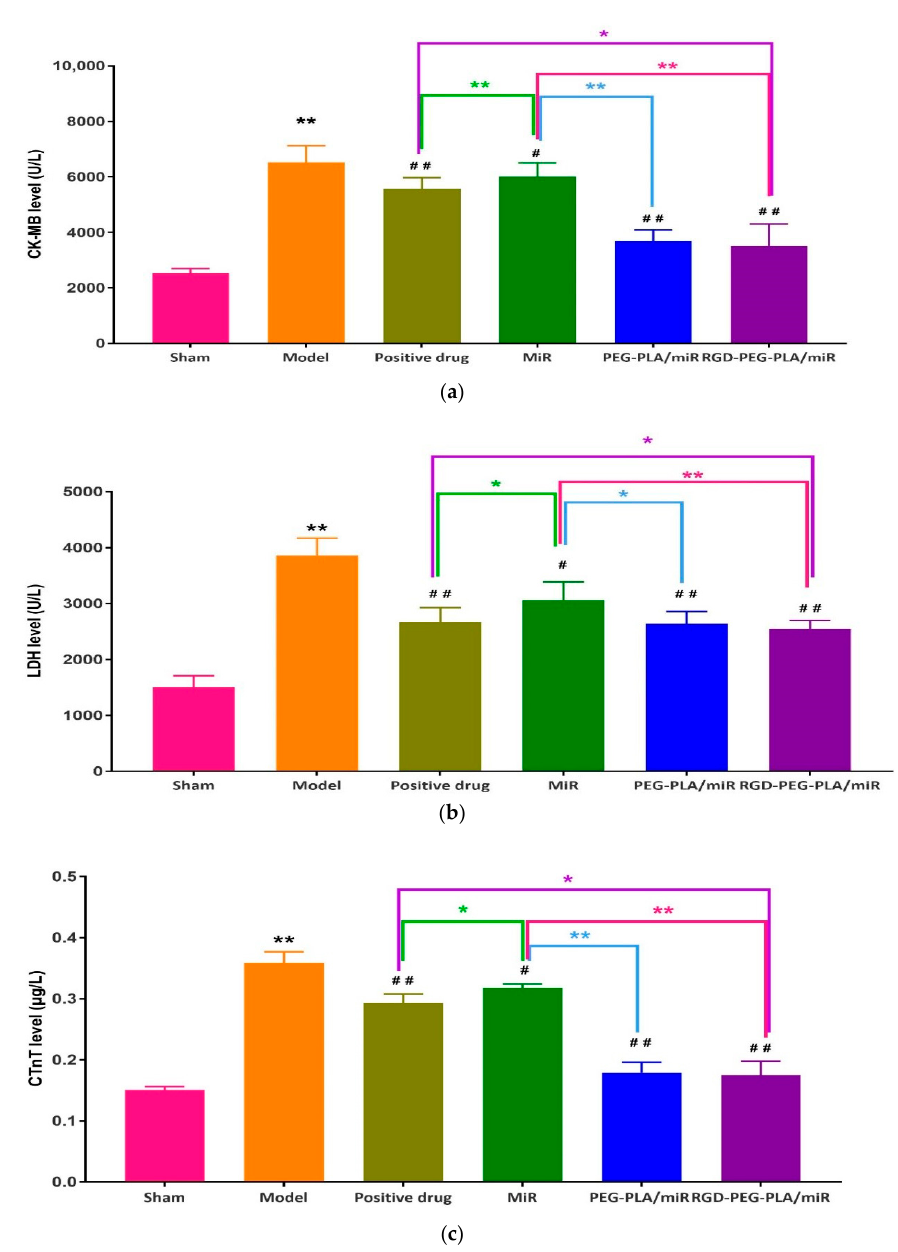
Figure 7. The levels of ( a ) creatine kinase isoenzyme (CK-MB), ( b ) lactic dehydrogenase (LDH), and ( c ) cardiac troponin T (cTnT) in six groups of rats (mean ± SD, n = 6). Compared with the sham group, the di ff erence was statistically significant (** p < 0.01). Compared with the model group, the di ff erence was statistically significant ( # p < 0.05, ## p < 0.01). The color asterisks indicate significant di ff erences between the two groups, * p < 0.05 and ** p <